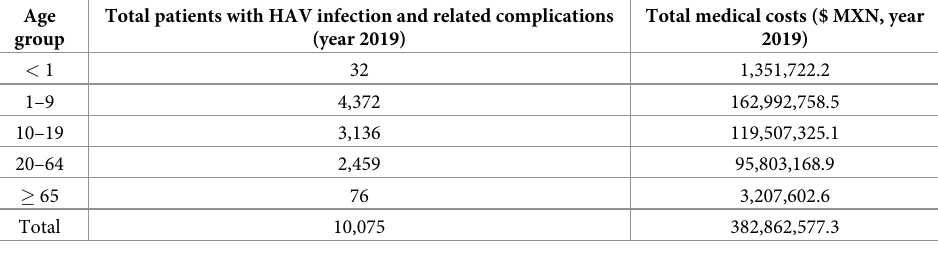
Table 3. Total cost of medical care of attention for patients with HAV infection and related complications (year